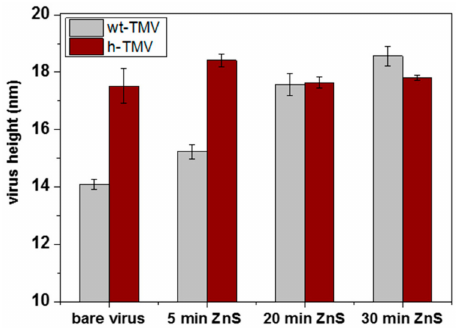
Figure 8. Virus height of not mineralized wt-TMV and h-TMV and the height of both virus types when mineralized with ZnS after 5, 20 and 30 min.